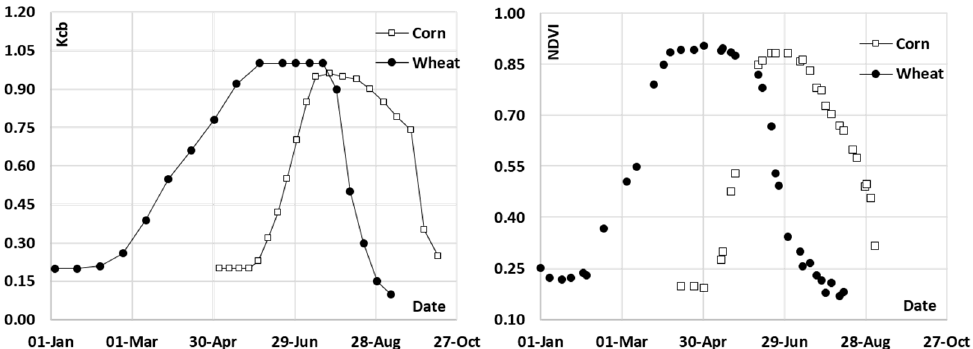
Figure 2. Comparison of the Kcb curves described by Wright, J.L. in 1983 [18] for wheat and corn and the temporal evolution of NDVI for both crops in Albacete (Spain) during the 2016 growing